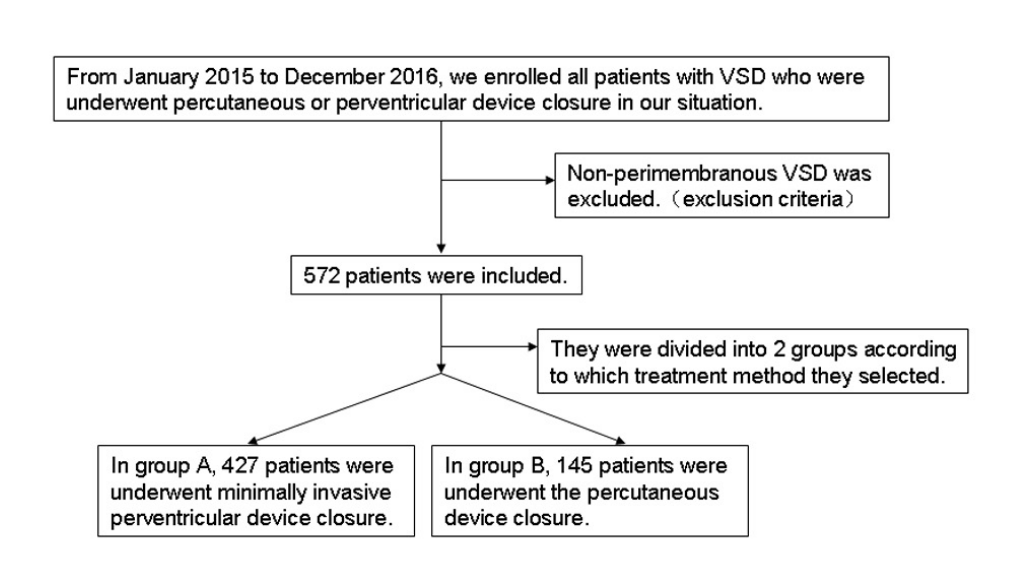
Fig. 1 – Patients flow chart. VSD=ventricular septal defect